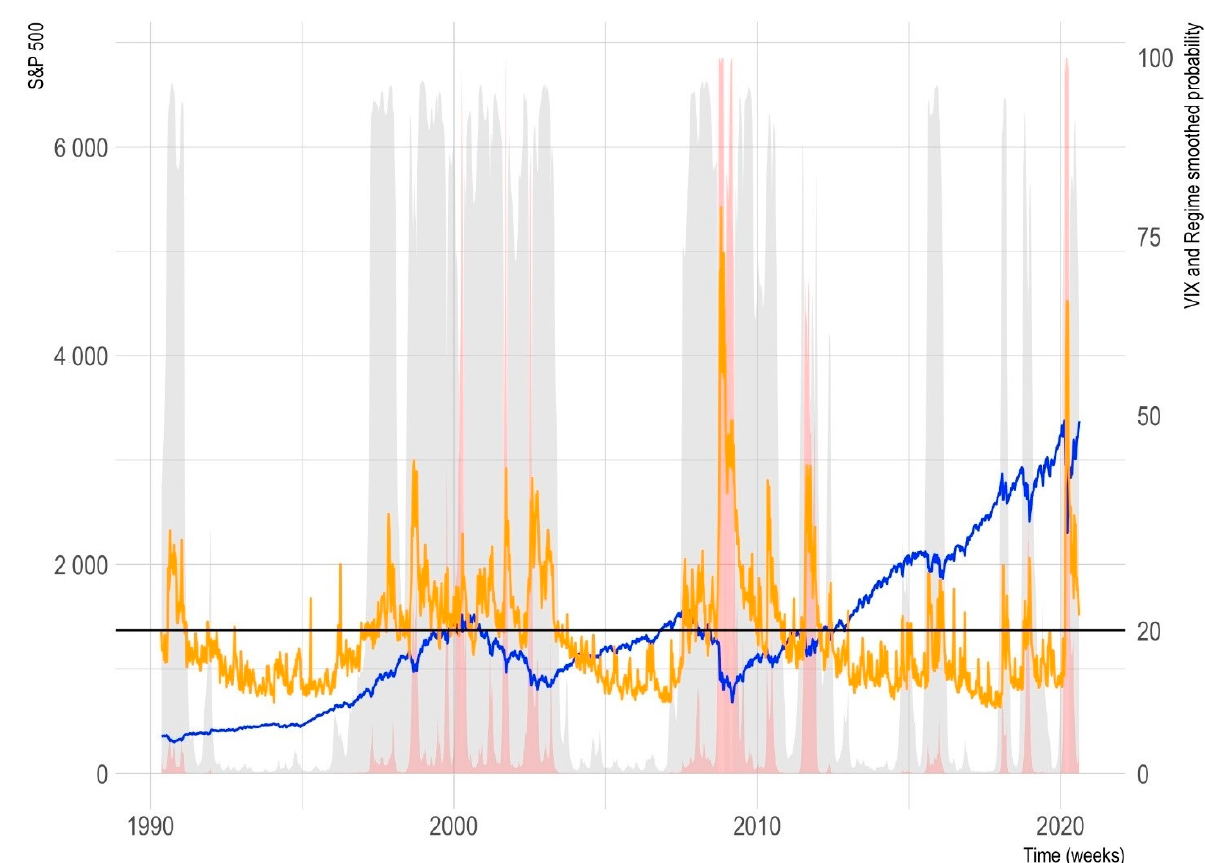
Figure 1. The historical performance of the S&P 500 and VIX indexes. Color codes: The S&P 500 is depicted with a blue line, the VIX index with an orange one, the high volatility regime probability at t is the grey area and the “extreme” volatility regime is the red one. Source: Own elaboration with data from Refinitiv [16].